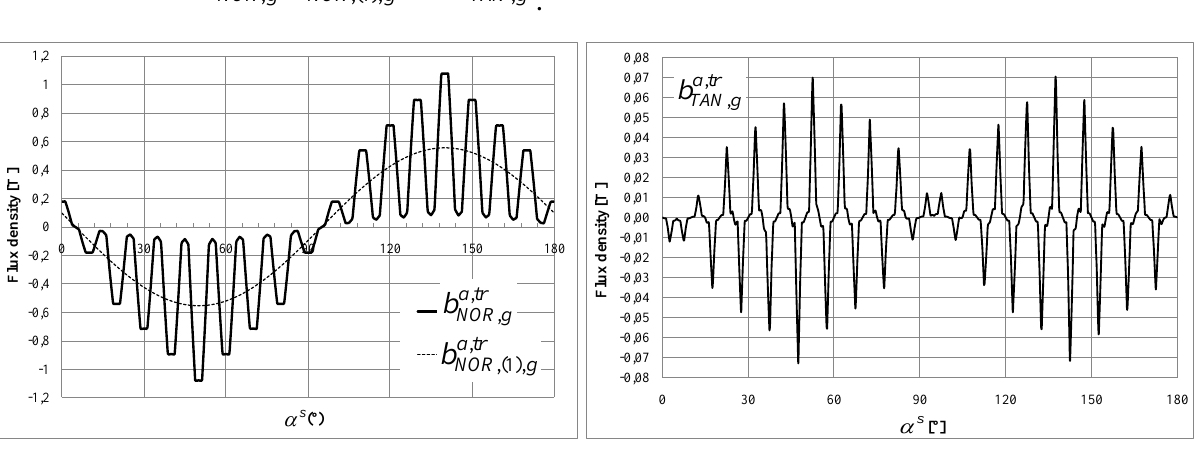
Figure 14. Variations along two poles of the normal and tangential air gap flux density